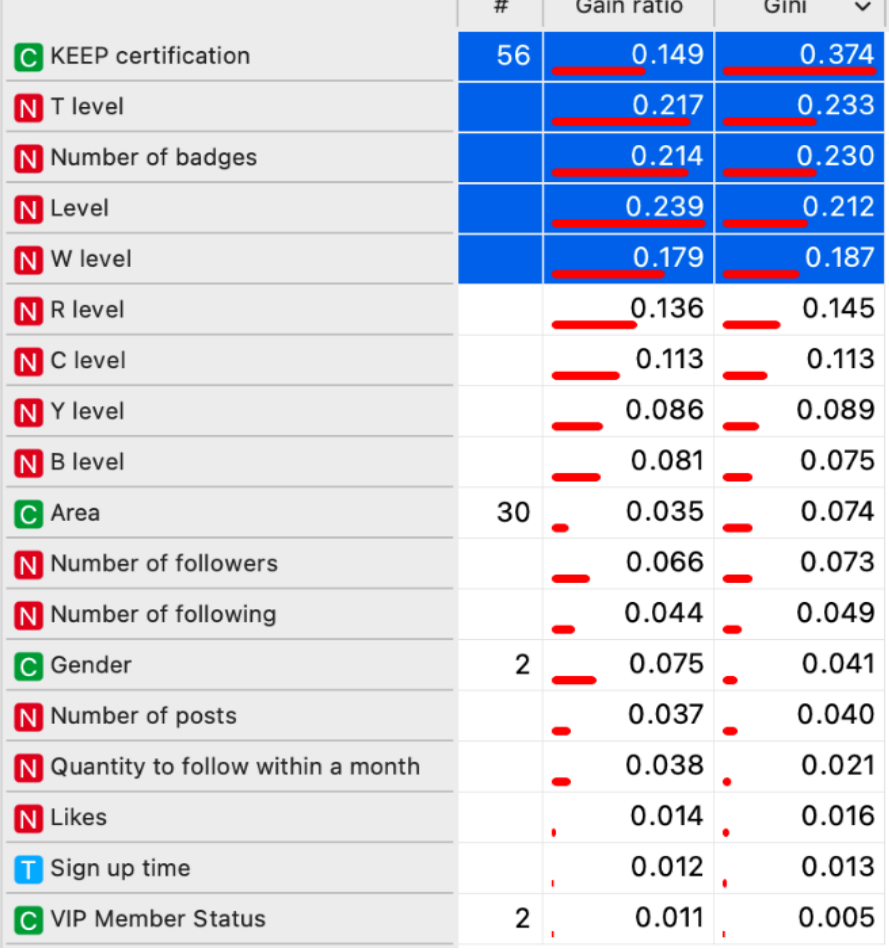
Figure 4. Ranking of predicted contributions of variables.